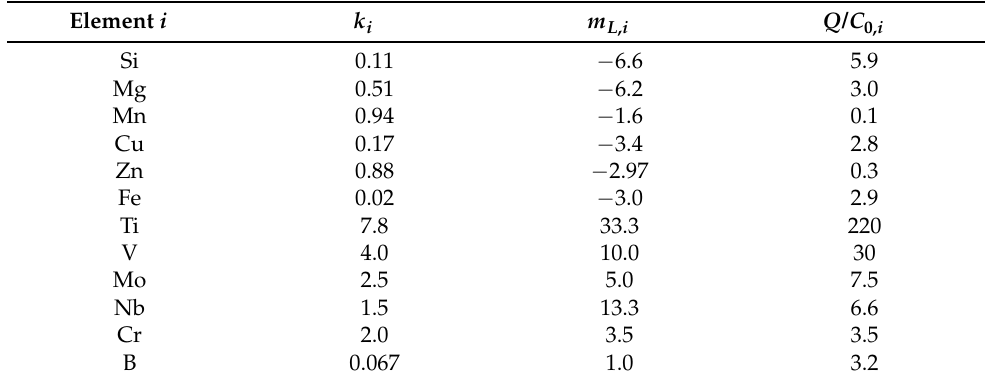
Table 1. Growth restriction factor Q of elements in solution with aluminum. Input data are based on binary phase diagrams